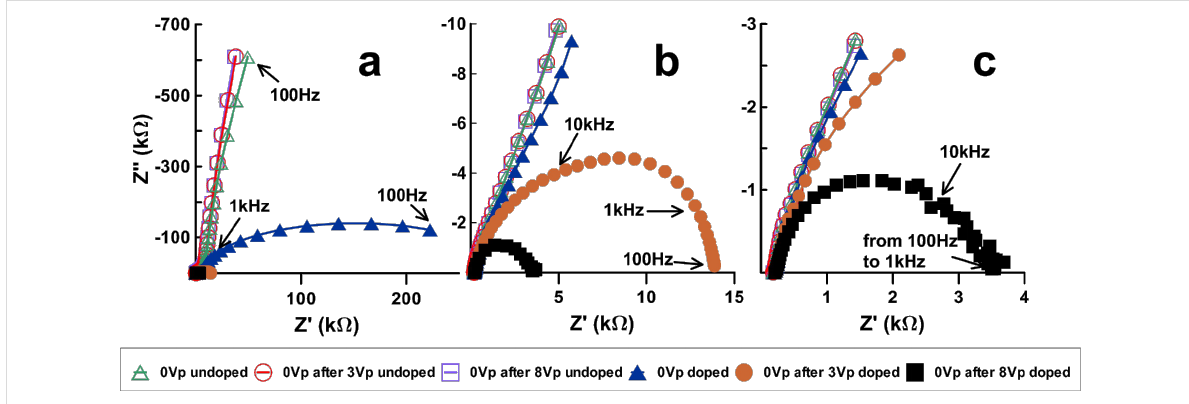
Figure 5: Impedance of unbiased doped (filled symbols) and undoped (unfilled symbols) samples at different instances of the driving sequence: initial 0 V, 0 V after V p = 3 V and 0 V after V p = 8 V. (a), (b) and (c) are different scales of the same graph.